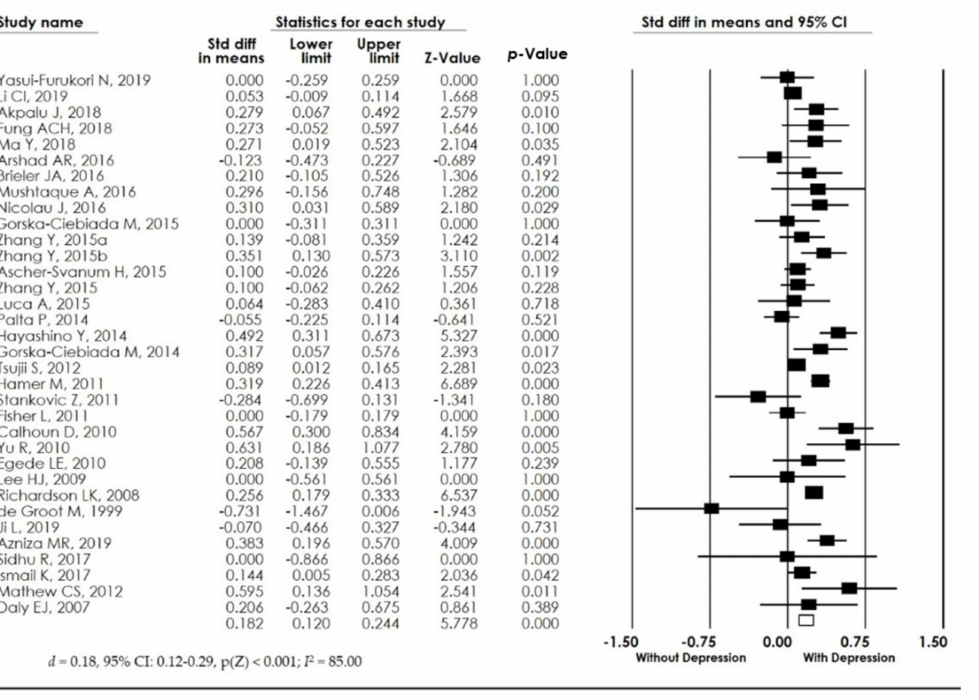
Figure 2. Forest plot of the meta-analysis for HbA1c levels in individuals with type 2 diabetes mellitus (T2DM) and depression versus individuals with type 2 diabetes mellitus without depression